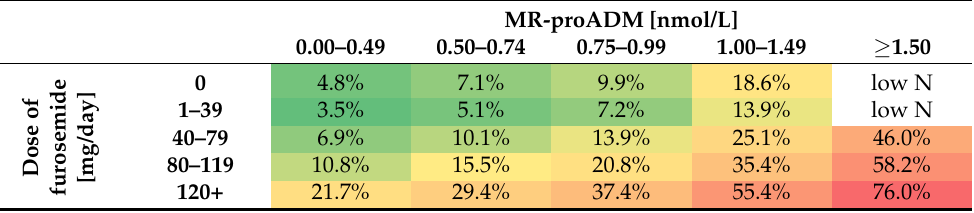
Table 4. Two-year probability of primary endpoint based on a multivariable logistic regression